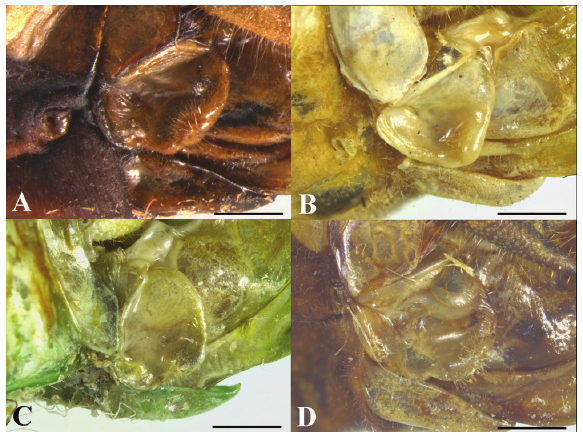
Figure 8. Bowl-like structures lateral at base of ovipositors of female Gonatoxia species. A. G. maculata B. G. helleri sp. n. C. G. immaculata D. G. furcata sp. n. Scale bars 1mm.